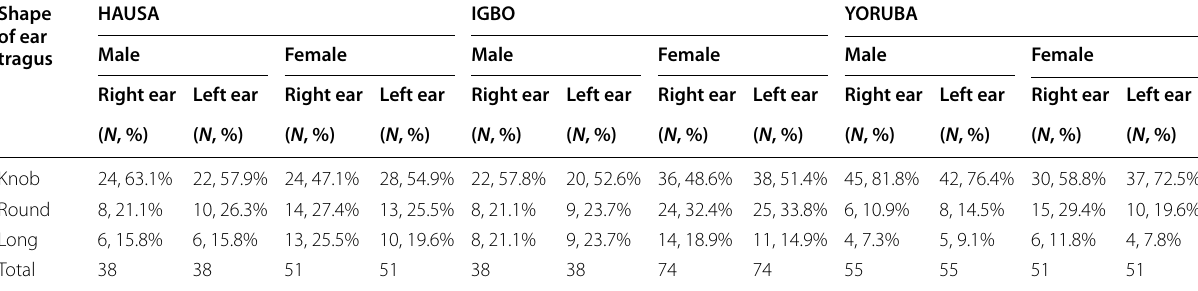
89; Igbo 112; Yoruba 106 = = =